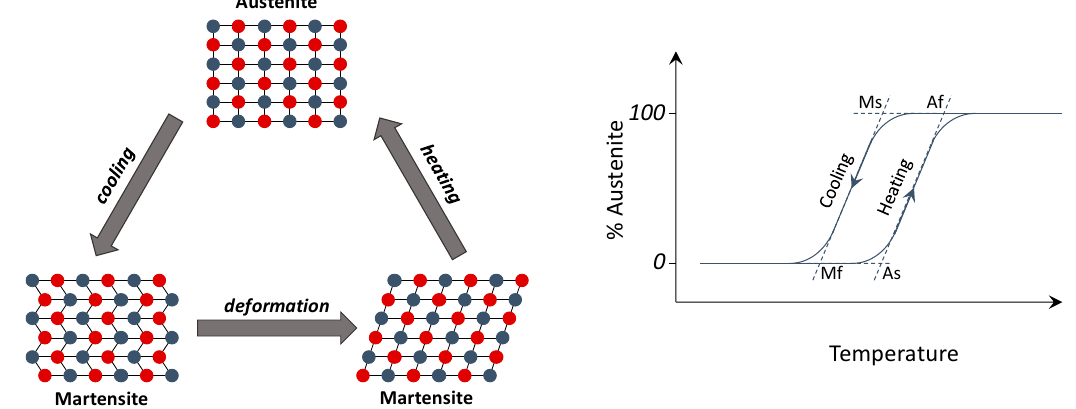
Figure 5. ( Left ) NiTiNOL transformation; ( right ) austenite variation as a function of the temperature.